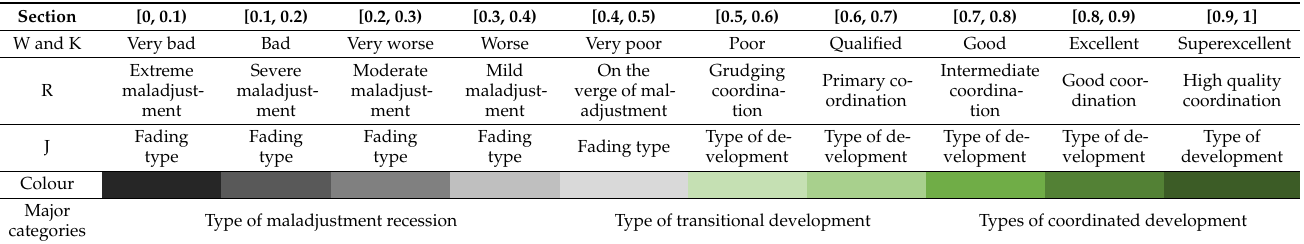
Table 4. Classification criteria for comprehensive evaluation index, coordination level and coordina- tion development